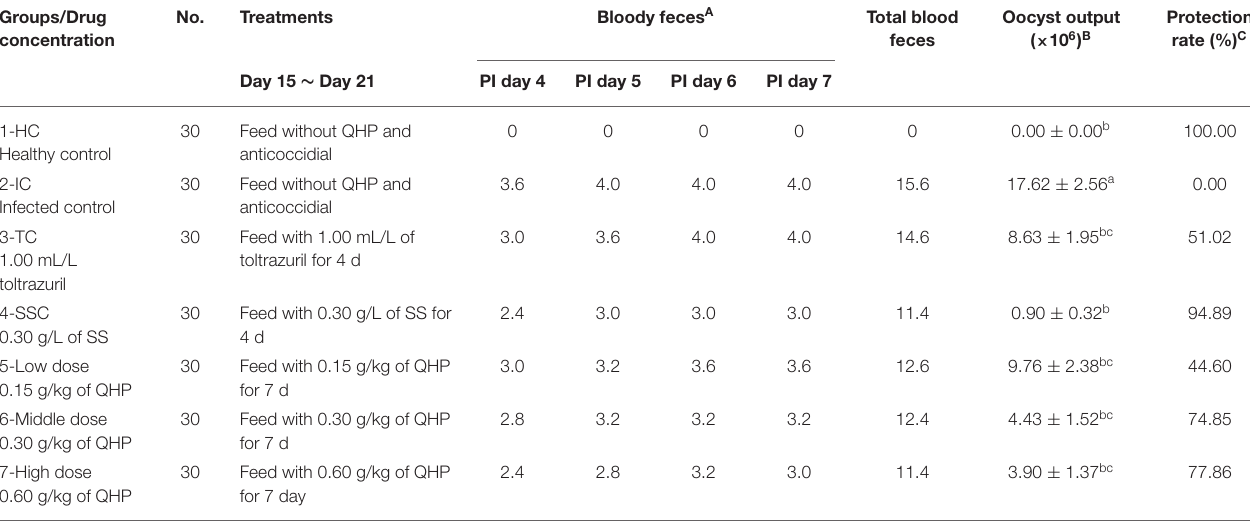
TABLE 1 | Effects of Qinghao Powder on bloody feces, oocyst output, and protection rate of chicks inoculated with Eimeria tenella . Groups/Drug